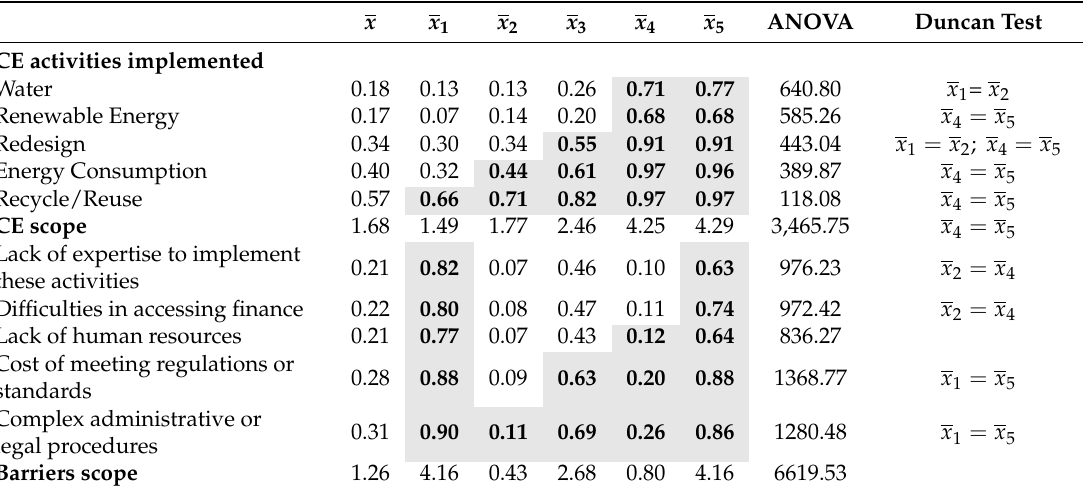
Table 4. CE behavior and